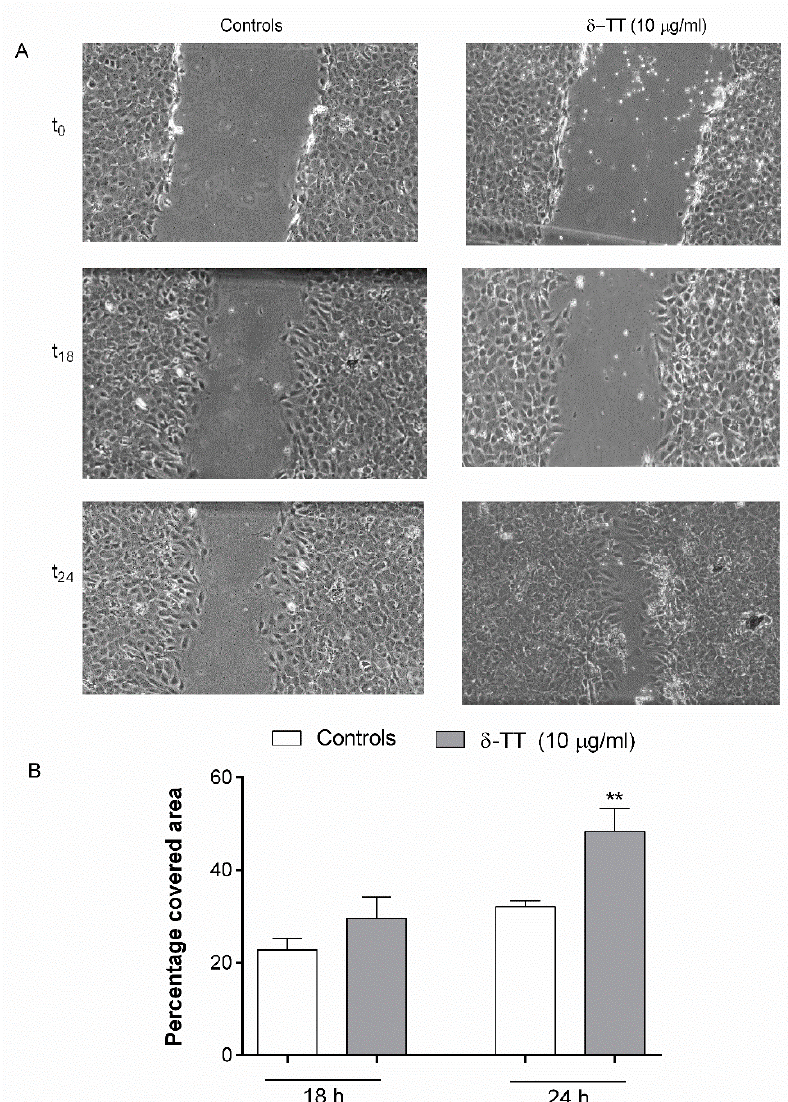
Figure 2. δ -TT (10 µ g / mL) promotes the migration of MC3T3-E1 cells in wound healing assay. δ -TT treatment was performed 24 h before and immediately after cells were scratched. ( A ) Wound healing assay of untreated and treated MC3T3-E1 cells; ( B ) Quantification of wound closure. The graph represents the wound width as the % of the closure of the original wound. Wound size was detected using ImageJ Software. The data are presented as the mean ± SEM of three independent experiments. ** p < 0.01 vs. controls.